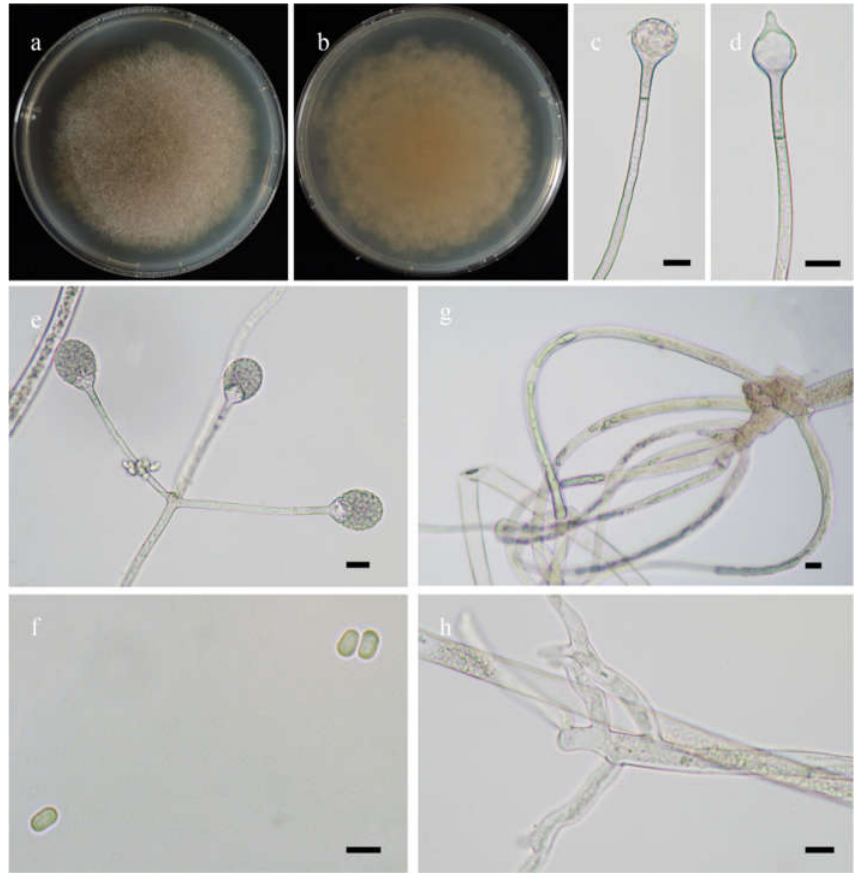
Figure 6. Morphologies of Absidia sichuanensis ex-holotype CGMCC 3.16258. ( a , b ). Colonies on MEA